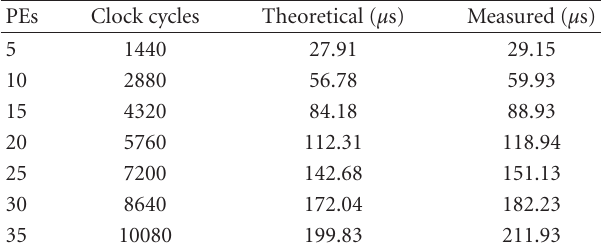
Table 4: The reconfiguration time, using shift register LUT re- configuration in the RTR